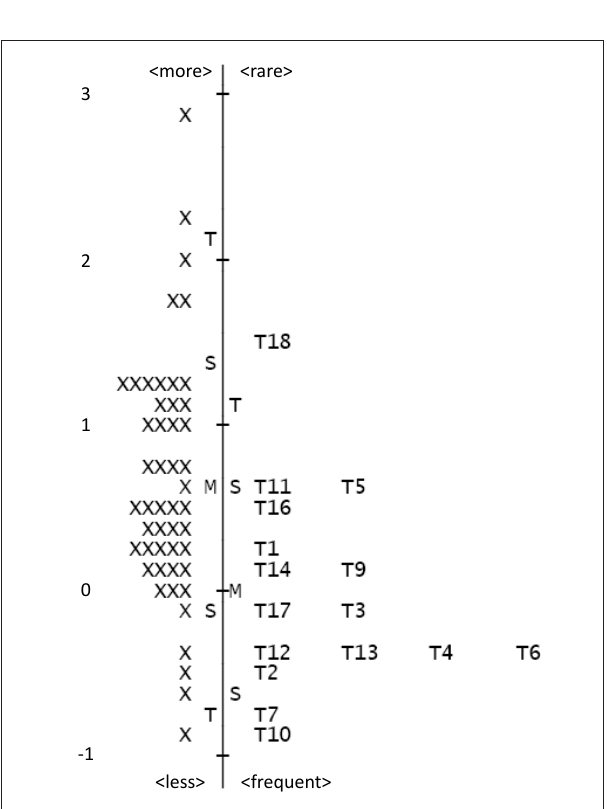
FIGURE 1 : Person-item